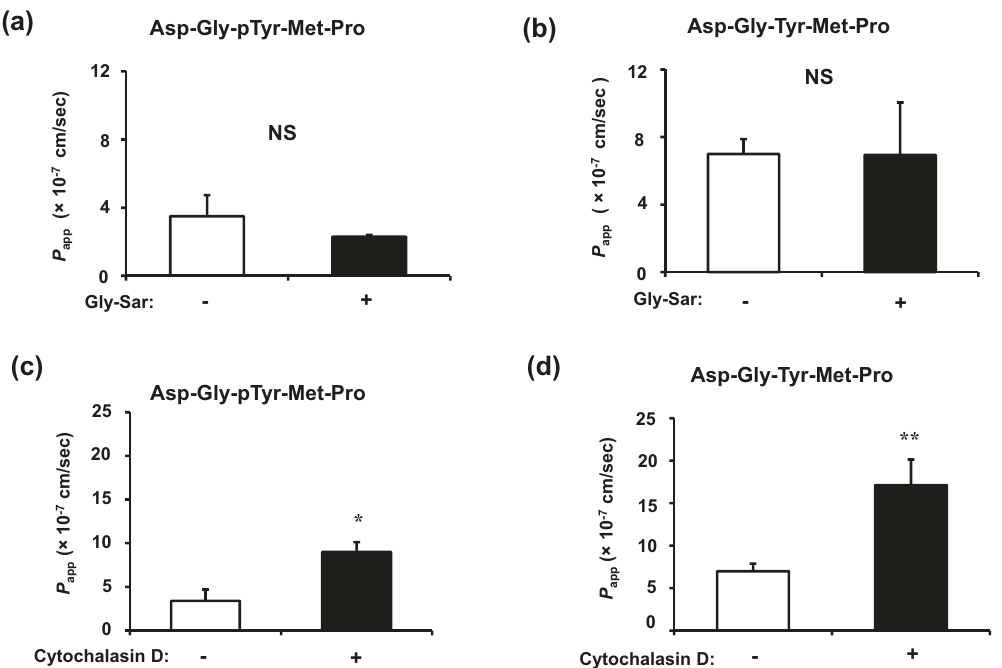
Fig. 2 Effects of Gly-Sar and cytochalasin D on transport of Cblin pentapeptides in Caco-2 cells. Effects of 10 mM Gly-Sar on transport of 1 mM Asp-Gly-pTyr-Met-Pro ( a ) and Asp-Gly-Tyr-Met-Pro ( b ) across Caco-2 cell monolayers for 60 min. Basolateral peptide concentrations were determined after 60 min by LC – TOF/MS. Effects of cytochalasin D on transport of 1 mM Asp-Gly-pTyr-Met-Pro ( c ) and Asp-Gly-Tyr-Met-Pro ( d ) across Caco-2 cell monolayers for 60 min. Caco-2 cell monolayers were incubated with or without cytochalasin D (0.5 μ g/mL) for 30 min. Basolateral peptide concentrations were determined by LC – TOF/MS. Values are expressed as means ± SEM, n = 4 – 6. * P < 0.05, ** P < 0.01. NS, not signi fi